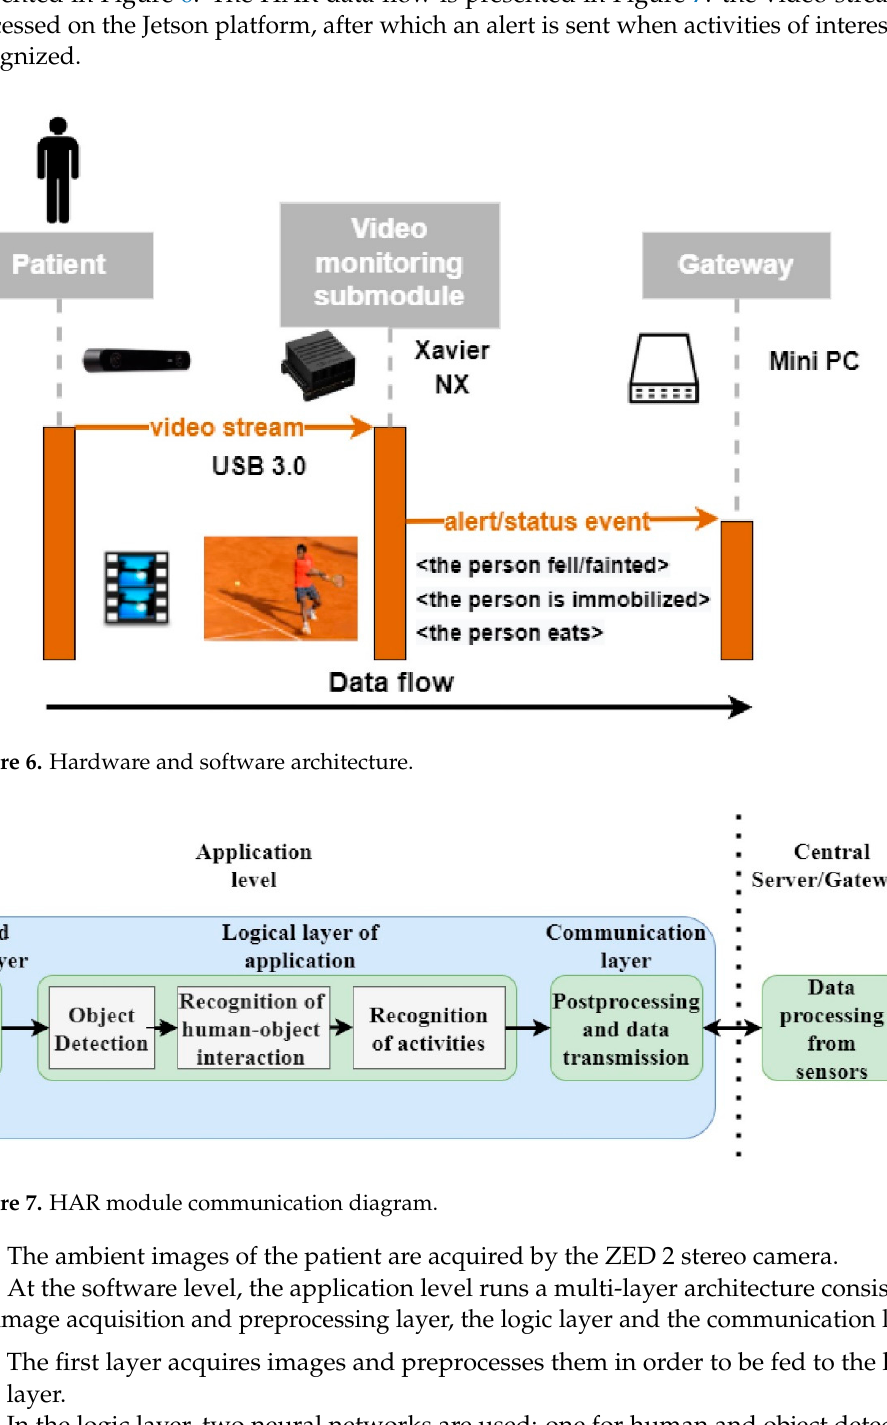
Figure 5. Examples of annotations in the dataset with a human doing multiple actions at the same time: ( a ) person lying on the bed and working on a computer and ( b ) person sitting on a chair, eating a sandwich and working on a computer [55].